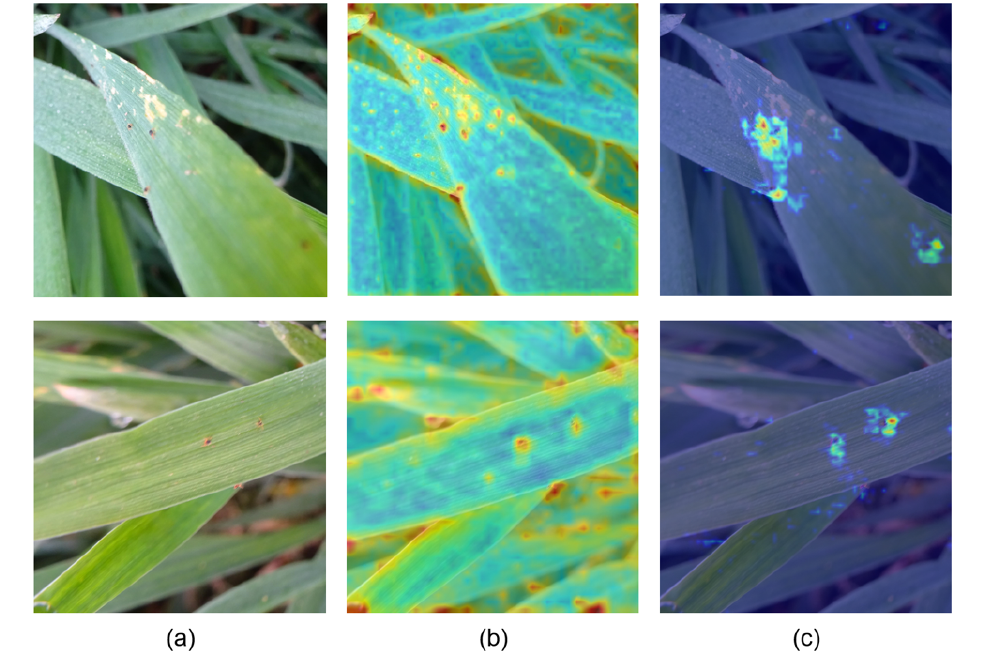
Figure 9. The visualization of thermodynamic feature maps of Backbone and FPN: ( a ) the original image; ( b ) thermodynamic map of Backbone ( c ) thermodynamic map of FPN.